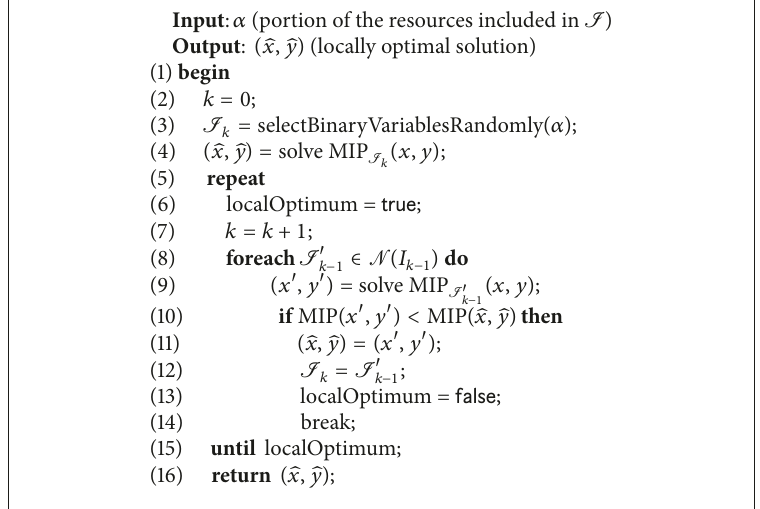
Algorithm 2: Next descent